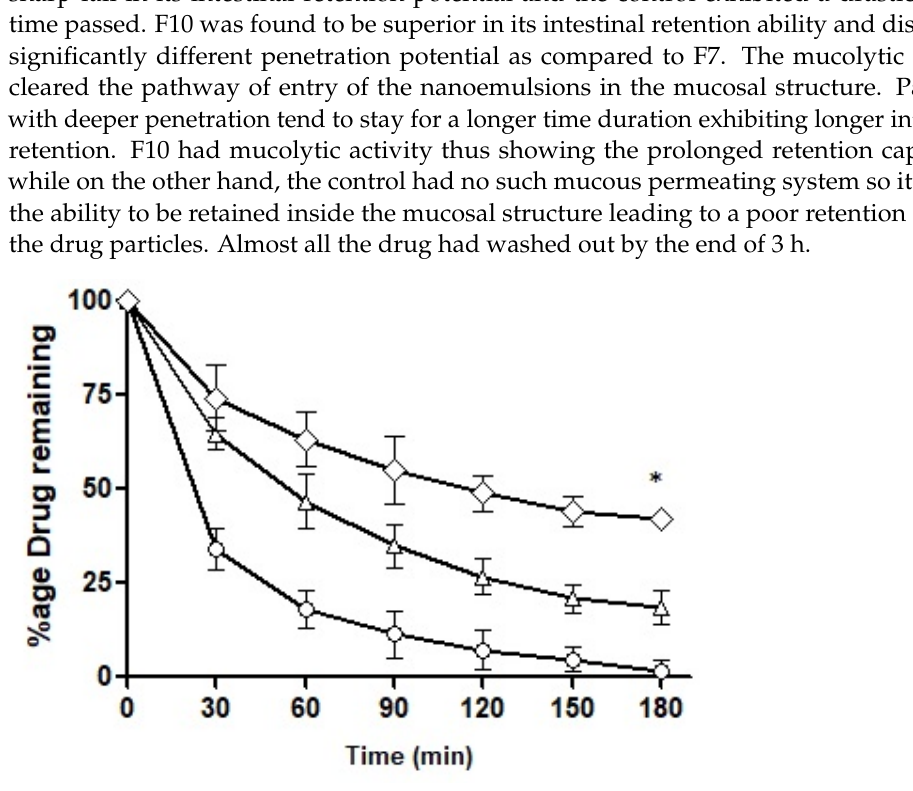
Figure 12. Percentage of ACV remaining on excised rabbit intestinal mucosa as free drug solution ( ◯ ), loaded into F7 ( △ ) and F10 ( ◇ ) being continuously rinsed with 0.1 M phosphate buffer pH 6.8 for 3 h. * indicates that the outcomes of F10 are significantly different than F7.